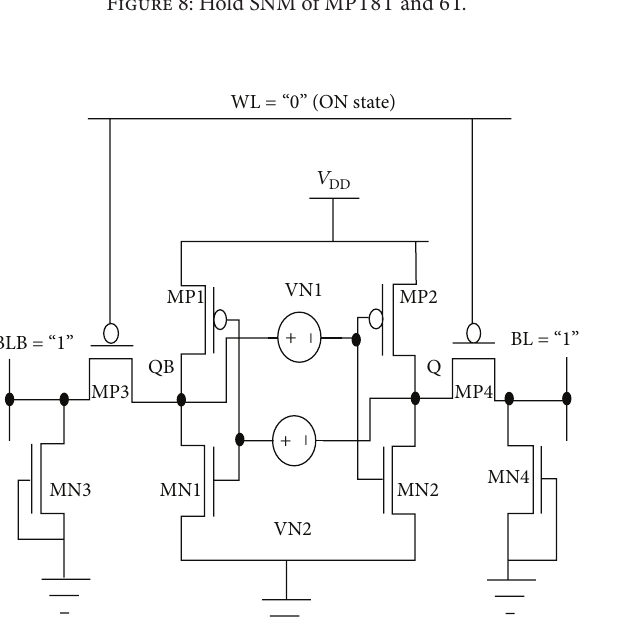
Figure 8: Hold SNM of MPT8T and 6T.